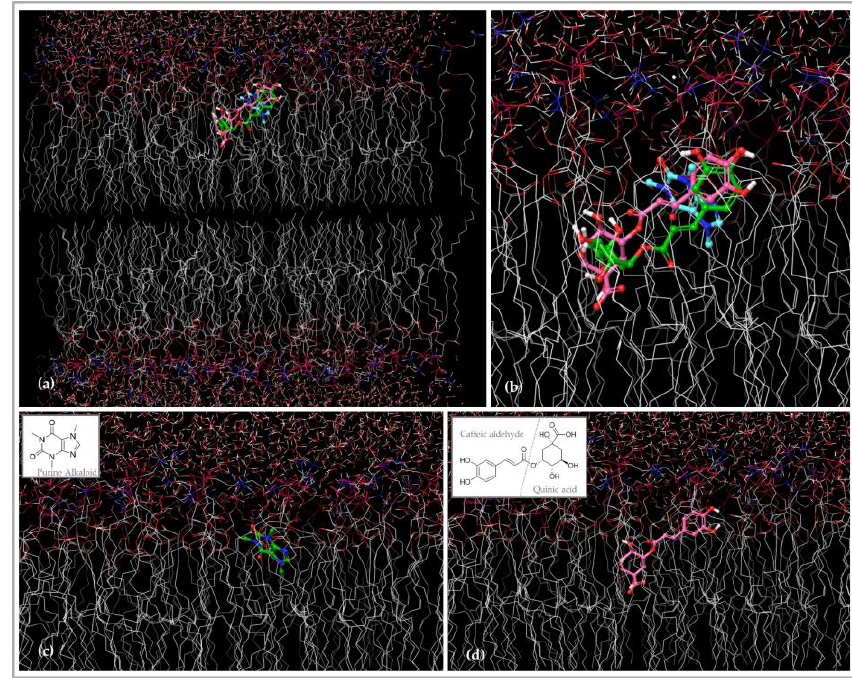
Figure 6. Simulated 3D model of grid of nano-phytosome bilayer docked with main phytochemicals of SI (caffeine and 5-caffeoylquinic acid). In the model, for better visualization, only polar hydrogens are represented. The lipid bilayer appears spherical (see also Figure 4). ( a , b ) show an overlap of the compound’s interaction with the lipid bilayer. ( c ) Caffeine (purine alkaloid); adjusted near a polar size with a minimum rate of hydrogen binding. ( d ) 5-Caffeoylquinic acid; the majority of hydrogen binding occurs due to caffeic aldehyde moiety.